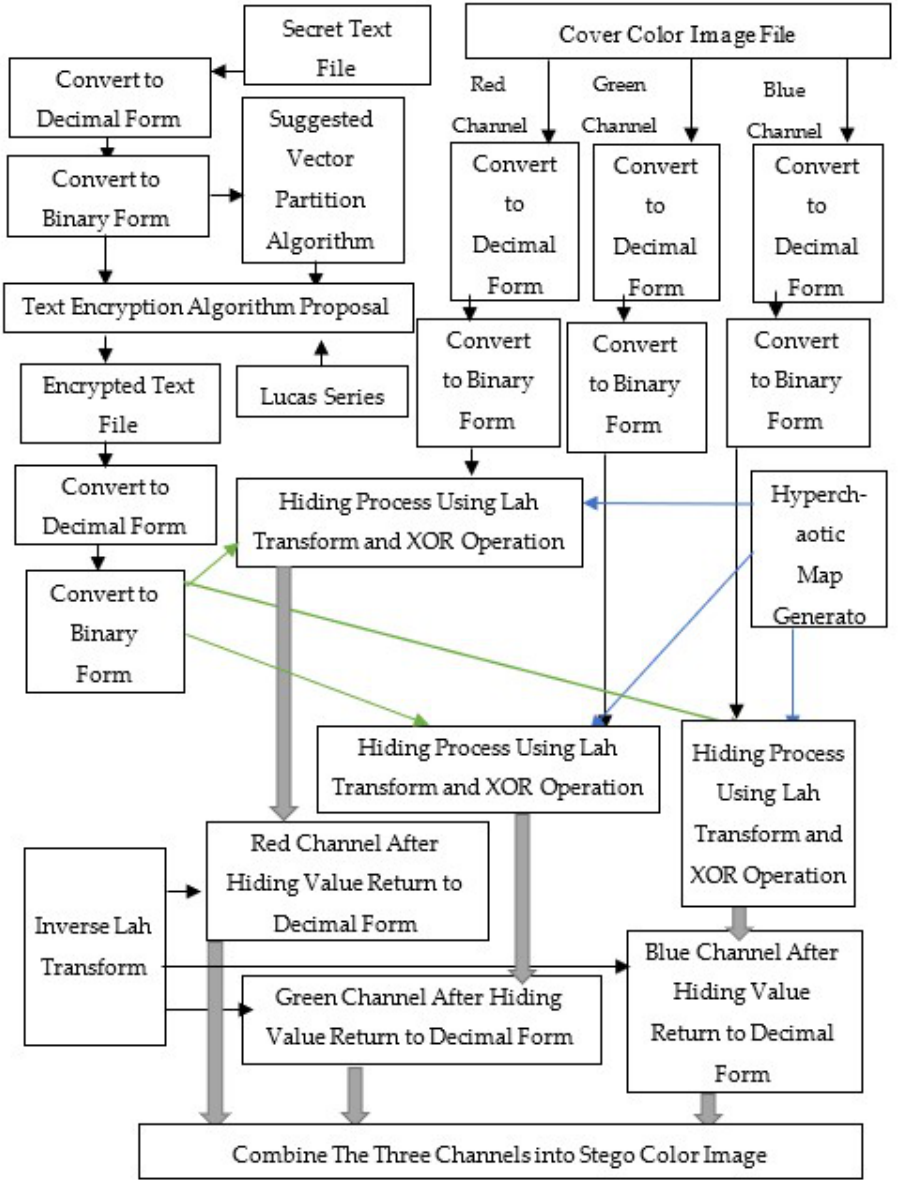
Figure 1. Proposed encrypted and hiding algorithms schema diagram.